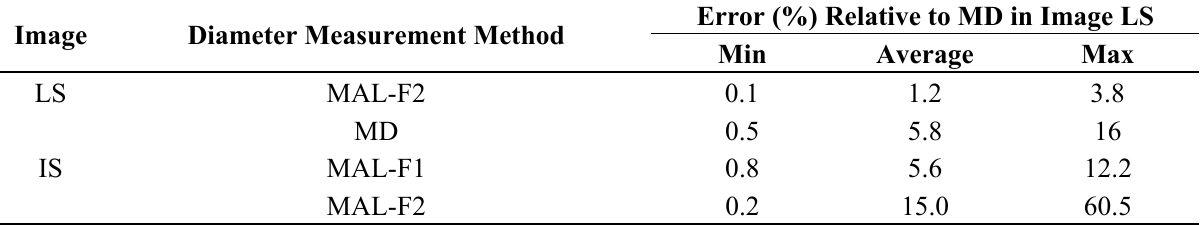
Table 5. Relative error in the estimate of fruit diameter: occlusion ratio lower than 33%. Image